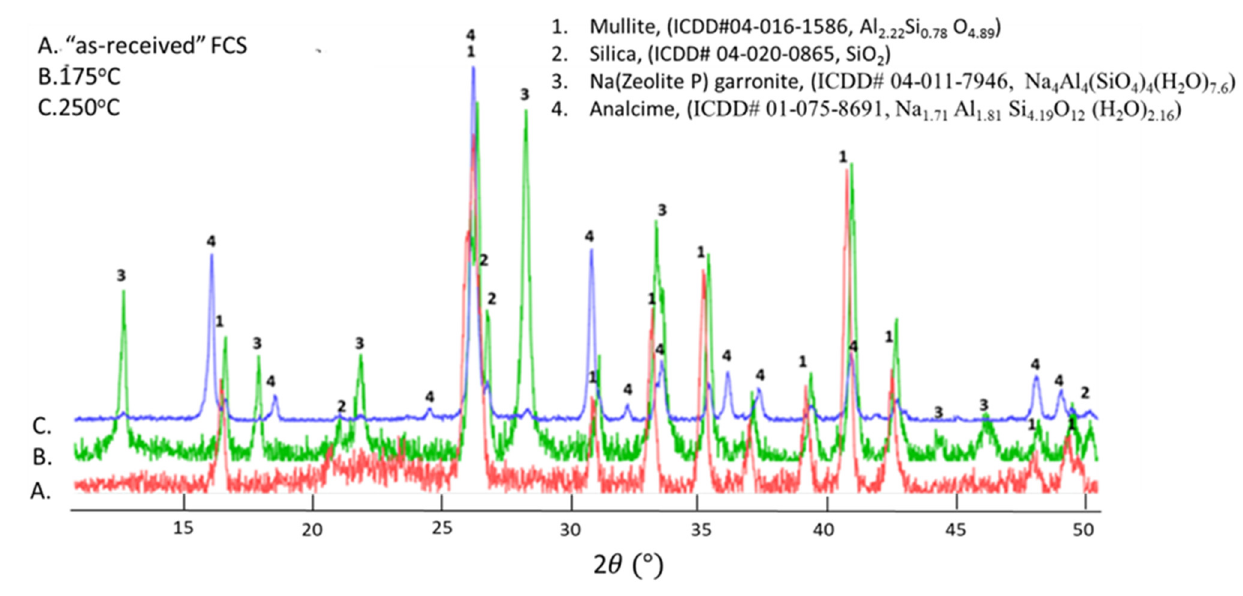
Figure 4. XRD patterns of “as-received” FCS, 175 ◦ - and 250 ◦ -autoclaved FCS/SMS blends. Two zeolite phases formed after autoclaving FCS-SMS at 175 ◦ C-garronite [(Na 4 Al 4 (SiO 4 ) 4 (H 2 O) 7.6 ] (patterns overlapping with that of Na-zeolite P) as the major phase and analcime (dehydrated) (Na 7.7 Al 7.7 Si 6.3 O 48 ) as a minor one. These two phases are the